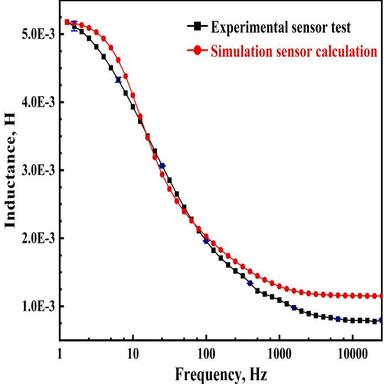
Comparison diagram of experimental and modelling inductance values.